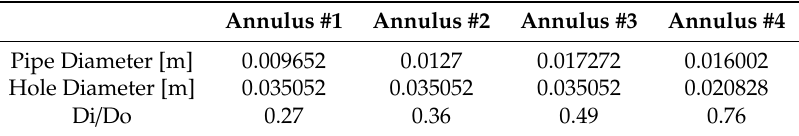
Table 1. Dimension of the annular sections used in the study.